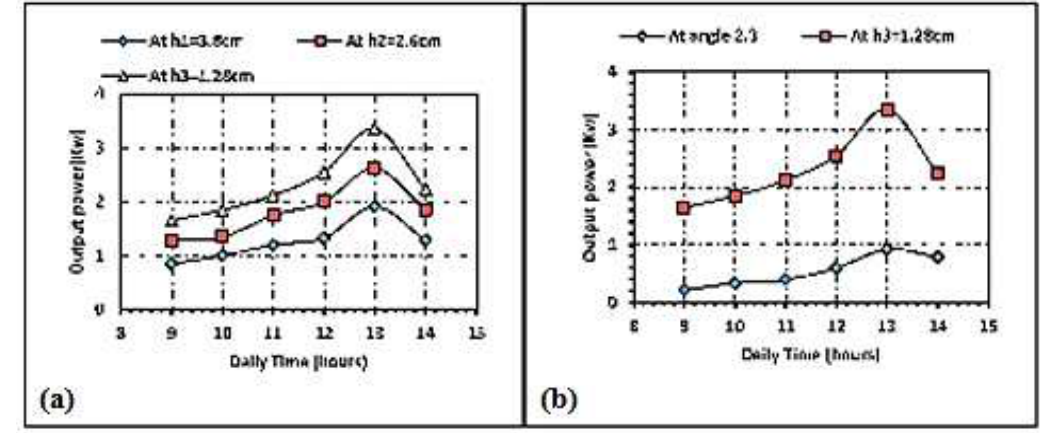
Fig. 11. Variation output power versus time (a)with reduction area.(b)with and without reduction area.